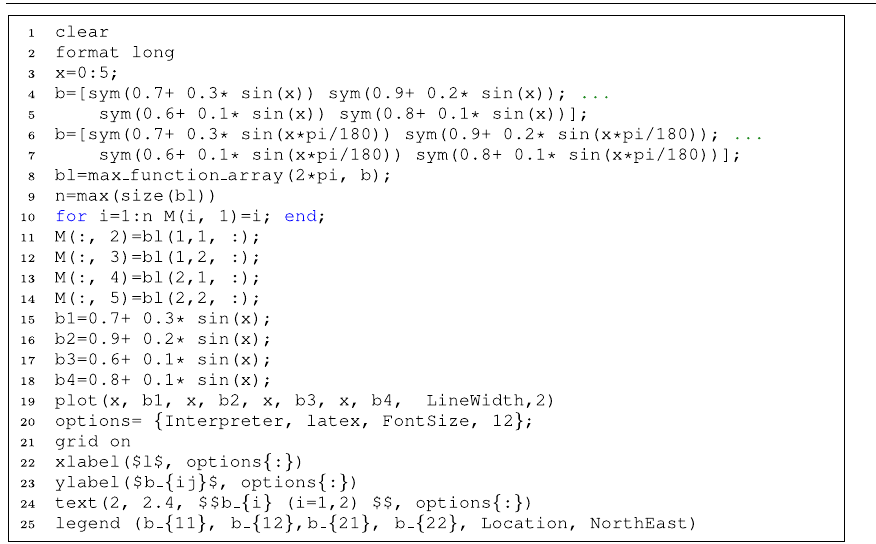
Algorithm 2 The MATLAB lines for computing b ij ( l